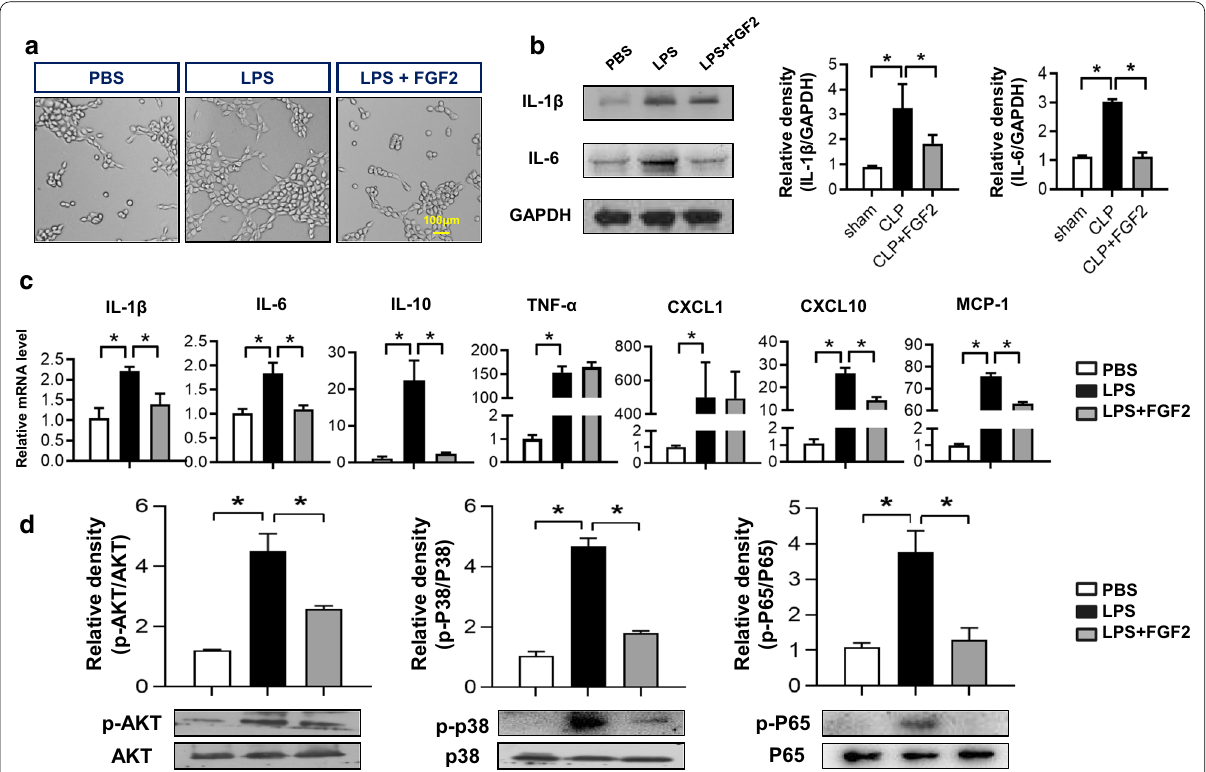
Fig. 4 FGF2 relieves lung endothelial cells inflammation induced by LPS. a Tube formation assay. HPMECs were seeded into 24-well plates covered with Matrigel antecedently in different medium and observed 3.5 h after LPS (1 μg/ml) with/without FGF2 (50 ng/ml) stimulation. b The inflammatory cytokine IL-1β and IL-6 protein levels of HPMECs 6 h after LPS were assessed by western blot and relative densities were analyzed (n 3 per group, GAPDH as a internal control)., while the protein levels of p-p38, p38, p-AKT, AKT, p-ERK and ERK was affected 0.5 h. c Relative gene ≥ expressions of inflammatory factors IL-1β, IL-6, IL-10, TNF-α, CXCL1, CXCL10 and MCP-1 was measured by quantitative real-time RT-PCR (n group). Data are represented as mean SEM. d The protein expressions of p-P38, P38, p-AKT, AKT, p-P65 and P65 in HPMECs which were stimulated ± by LPS for 0.5 h were measured by western blot analysis and relative densities were quantified respectively (n